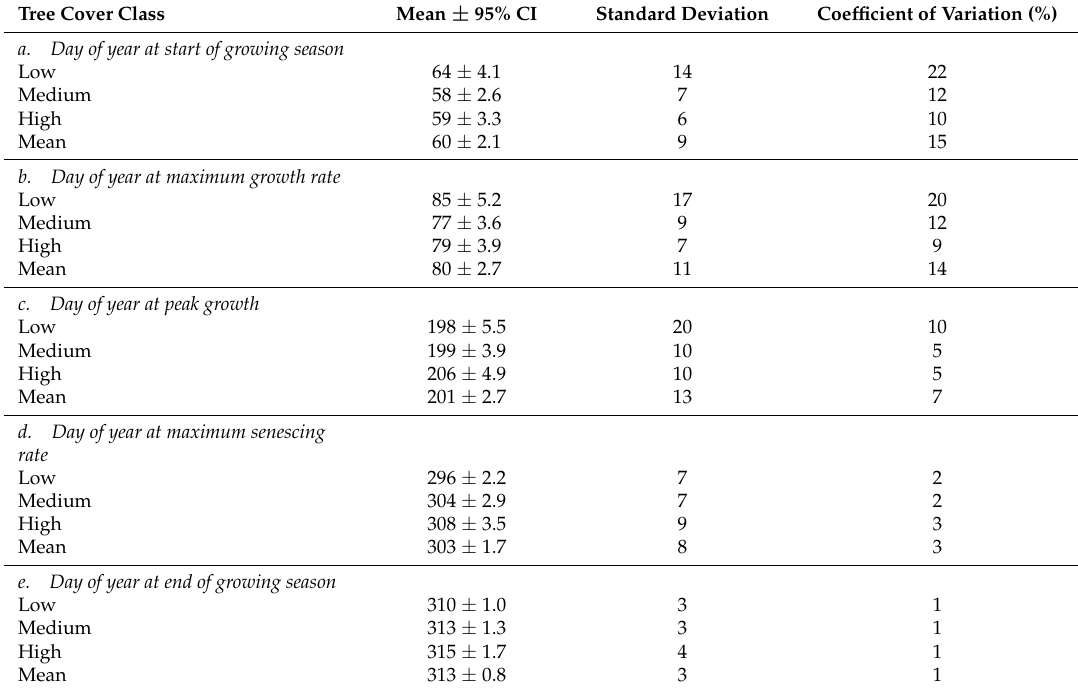
Table 2. Statistics of land surface phenological metrics for three tree cover (%) classes; Low (<20%, n = 44), Medium (20–40%, n = 22) and high (>40%, n = 34), derived from 14-year median maps. The austral year used in the study ranges from 4 July (Julian Day 185) of one year to 26 June (Day